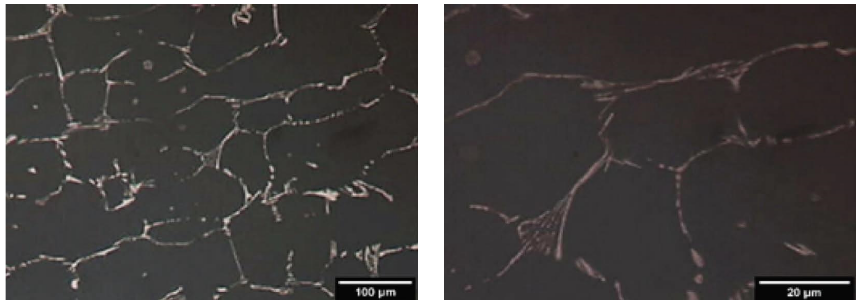
Figure 4: Microstructure of 2V-13W steel in the as-cast condition.